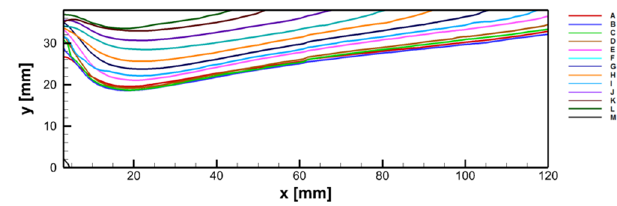
Fig. 6. Limits of the back- fl ow regions.